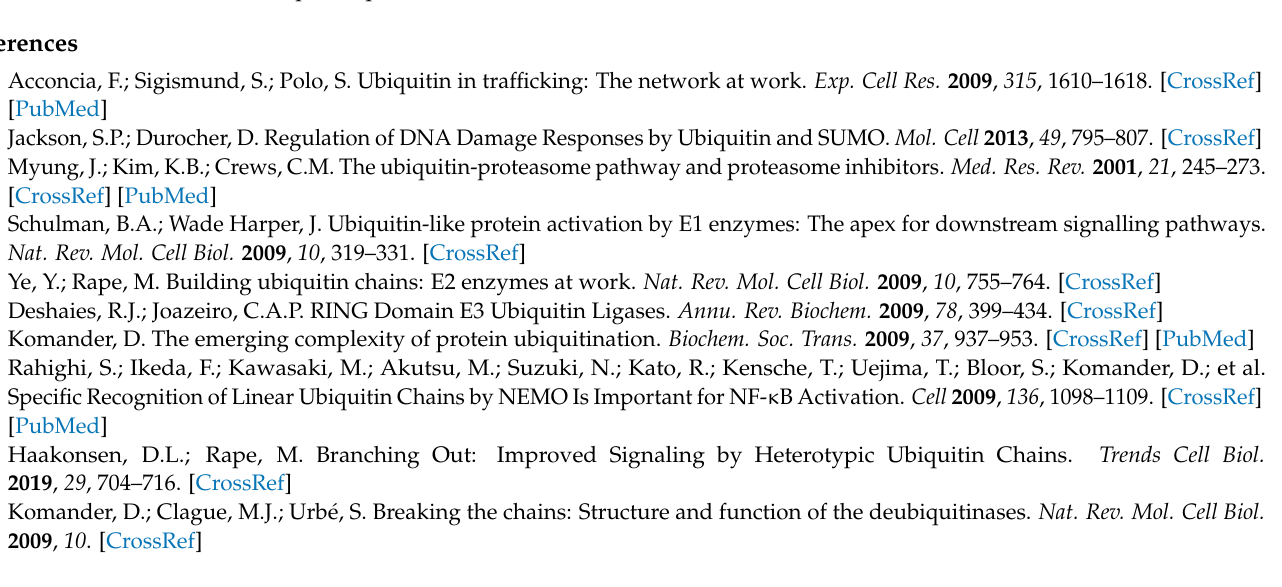
Supplementary Materials: The following are available online, Scheme S1: Synthesis of p-ethynyl- Figure S1: Dose-response curves for analogs 1 (A) and 34 (B) against UCHL3 Figure S2: Proposed cyclization of glutamate-fluoromethylketone, Figure S3: Dark-exposure HA-immunoblot data for KMS11, Table S2: Cell lines and culture conditions, Table S3: Detailed information for shRNA vectors. Synthetic procedures and characterization of molecules also